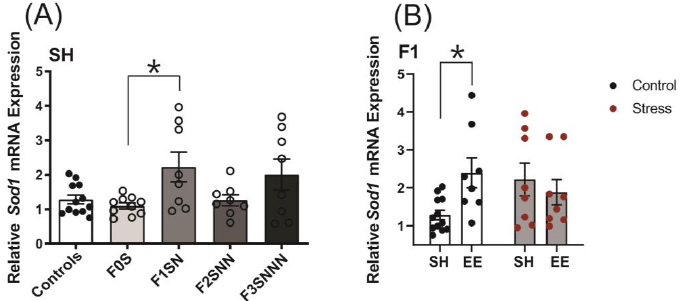
Figure 12. Uterine expression levels of the antioxidant enzyme Sod1 were significantly increased in F1 stressed animals and in F1 controls subjected to EE conditions. ( A ) Expression of Sod1 in uteri of stressed F0–F3 dams compared to controls. ( B ) Uterine expression of Sod1 in F1 females exposed to stress and EE housing compared to controls and SH. Asterisks indicate significance: <0.05 (*). Data are compared to F0N, mean ± SEM. Ordinary one-way ANOVA ( A ) and two-way ANOVA ( B ) analyses were used. N = 8–12 per group. SH = standard housing; EE = enriched housing; F = filial generation; S = stressed; N = nonstressed.